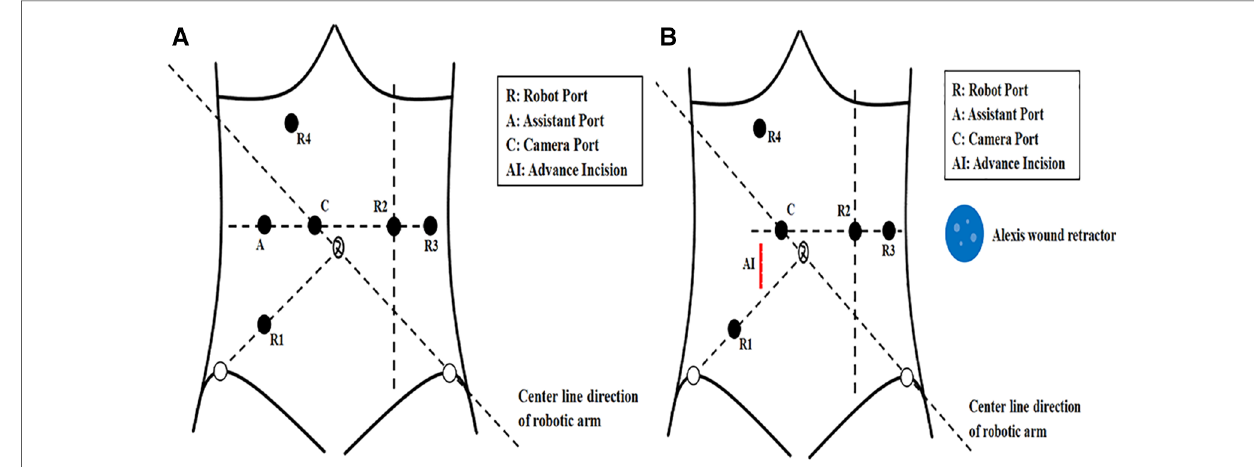
FIGURE 1 ( A ) The port placement in the intraoperative incision group. ( B ) The advance incision and port placement in the advance incision group.